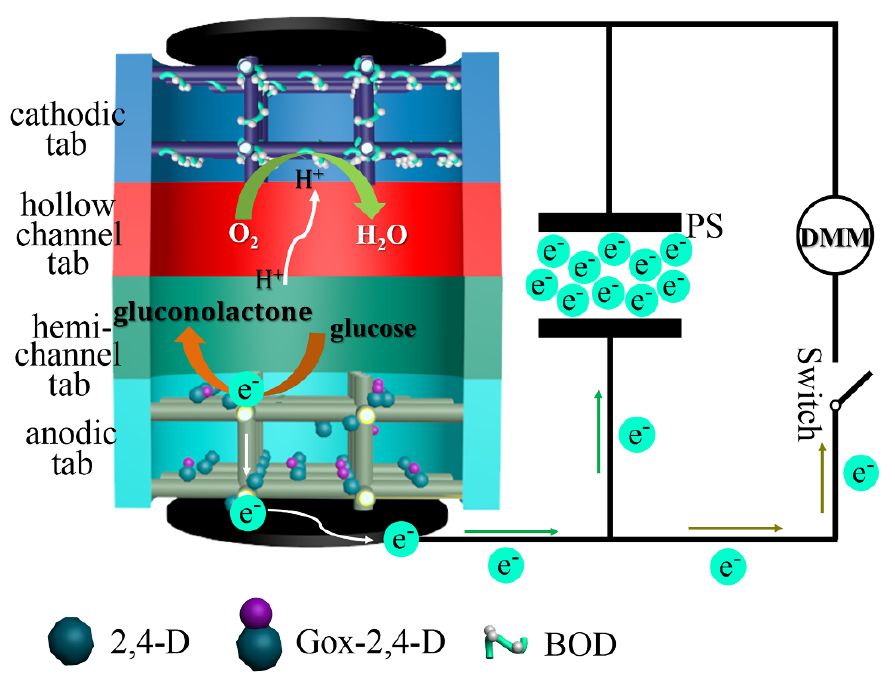
Scheme 1. Schematic illustration of the working principle of the assembled paper − based enzyme biofuel cells for self − powered sensing.